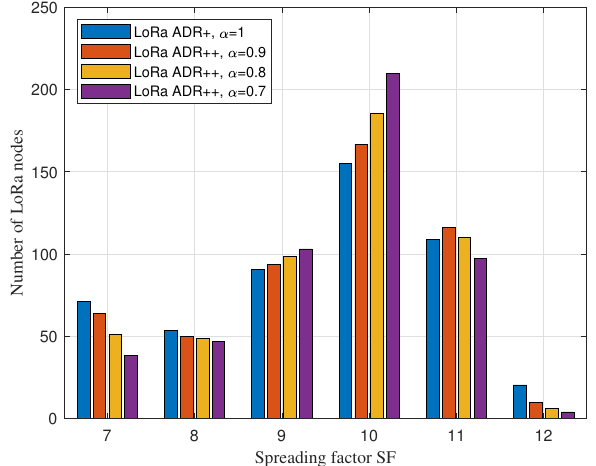
Figure 4. Number of LoRa nodes in each SF with different value of α in urban scenario with 500 LoRa